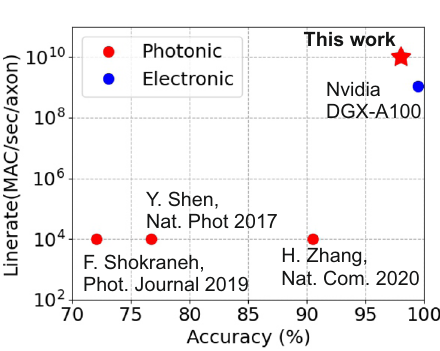
The solid lines represent the numerically simulated results and the points the experimentally acquired measurements.